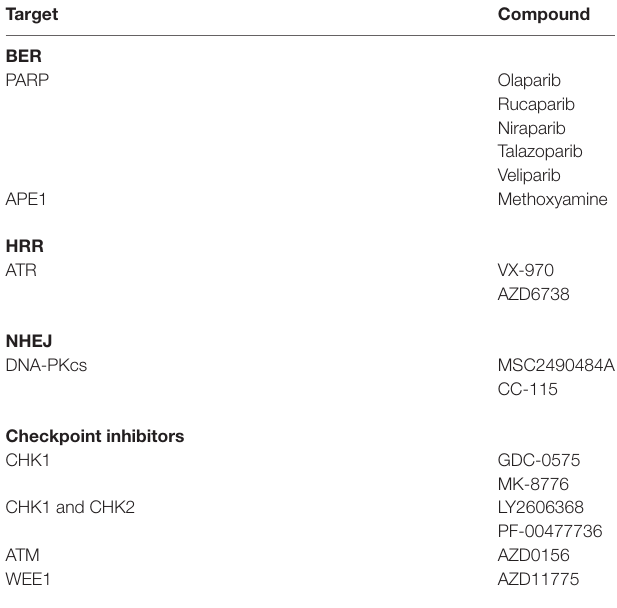
TABLE 2 | DNA damage response inhibitors in clinical